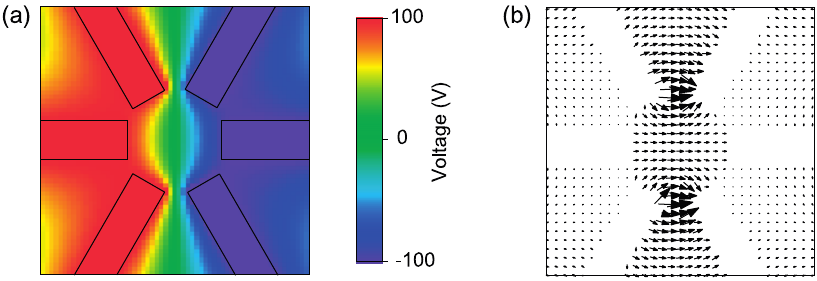
Figure 3. ( a ) Calculated potential in the NLC defect layer obtained by applying a rectangular voltage of 200 V with Φ = 0°; ( b ) Calculated electric field vectors in the NLC defect layer.